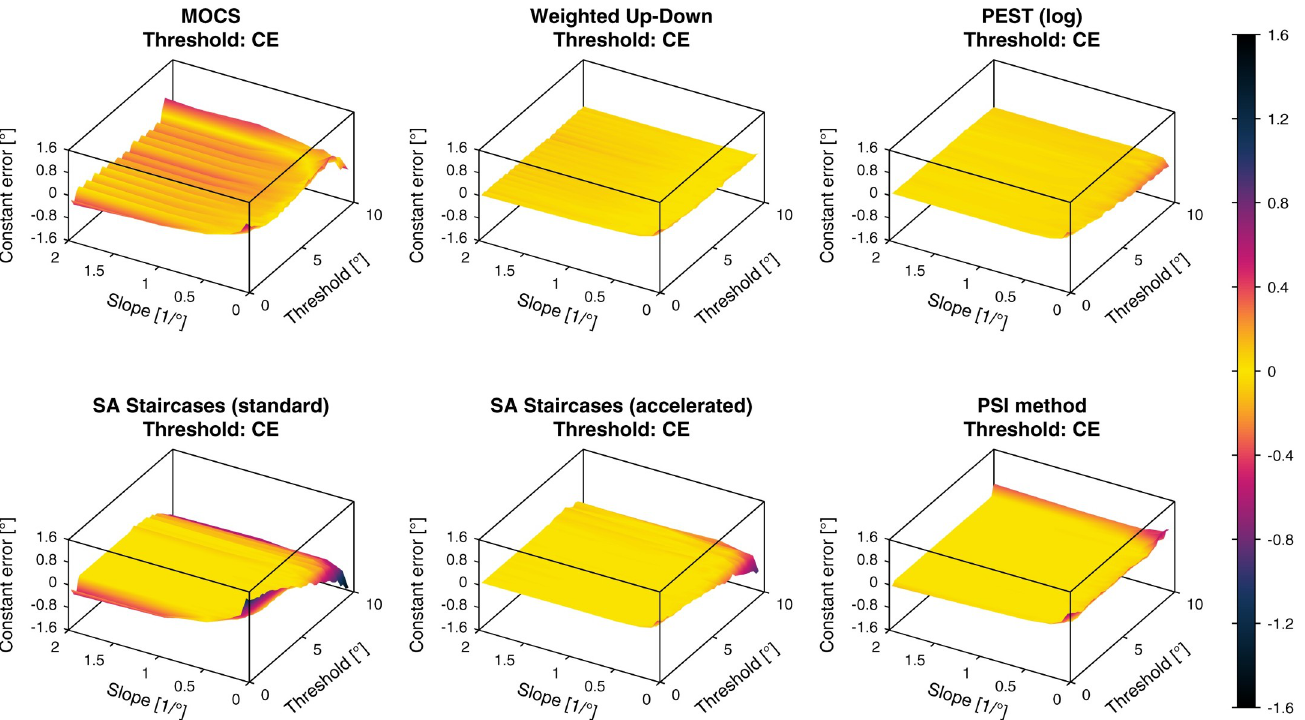
Fig 6. Constant errors of threshold estimates. Constant errors ( CE ) of the threshold estimates for the six different simulated sampling procedures. The color bar indicated the CE values in (˚).